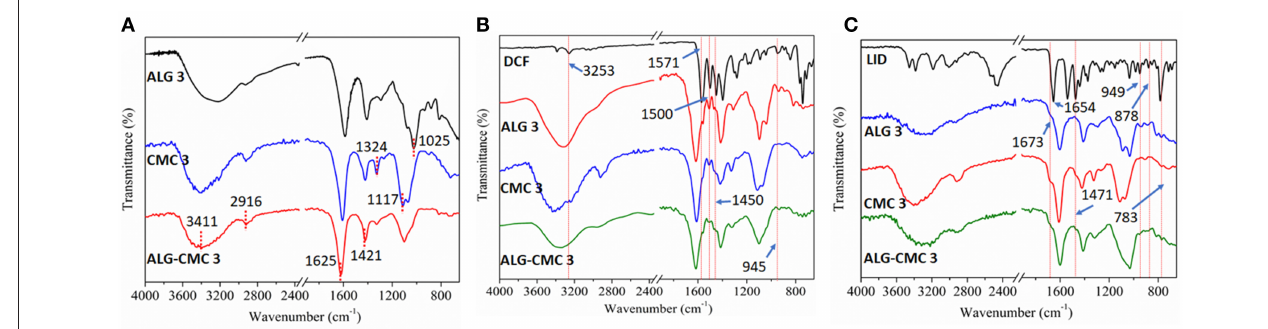
FIGURE 3 | ATR-FTIR spectra of drug-free (A) , DCF-loaded (B) , and LID-loaded (C) polymers.